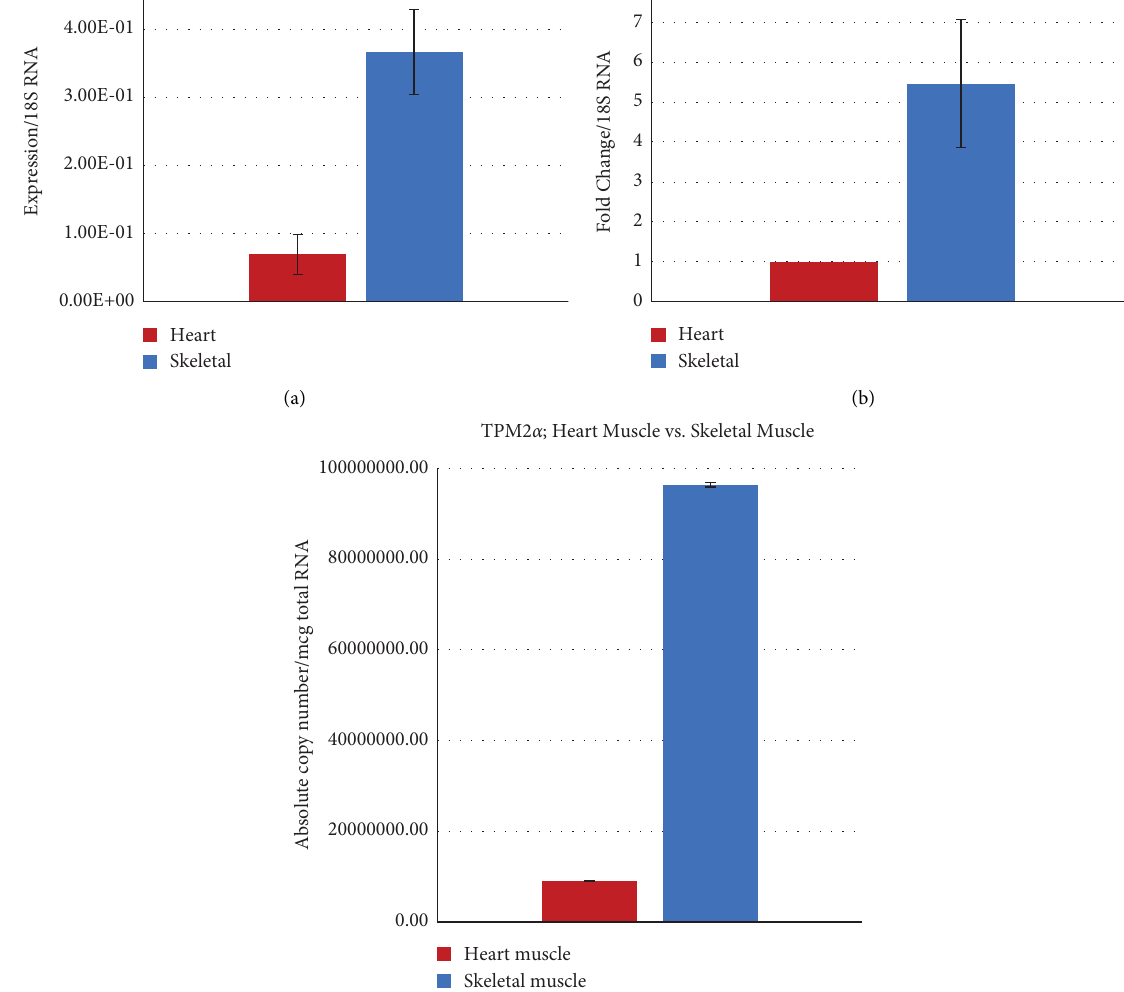
Figure 6: Relative and absolute expression of TPM2 α in Cyn striated muscles. (a) Relative expression of TPM2 α using the dCt method in the Cyn heart and skeletal muscle. (b) Fold change of TPM2 α in the Cyn heart and skeletal muscle using the ddCt method. (c) Determination of the absolute copy number of TPM2a in the Cyn heart and skeletal